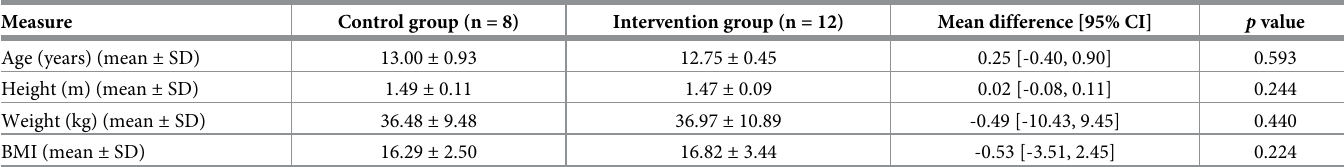
Table 1. Sample characteristics.